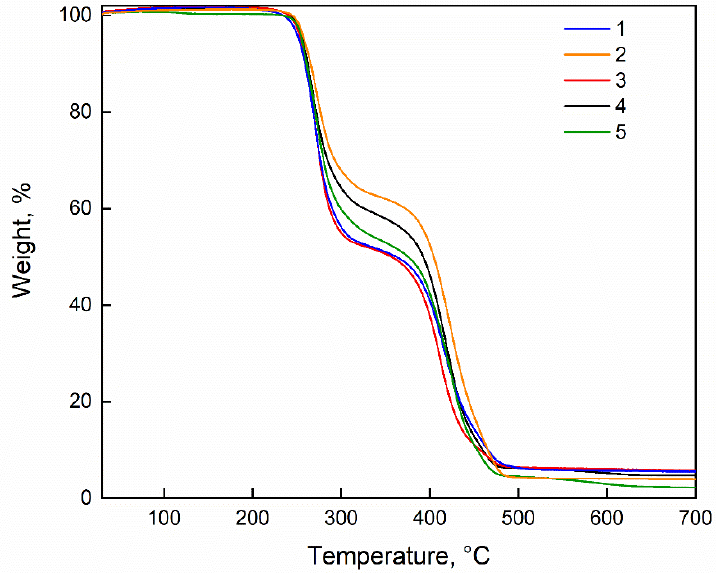
Figure 5. Thermogravimetric curves for all the samples in nitrogen atmosphere.